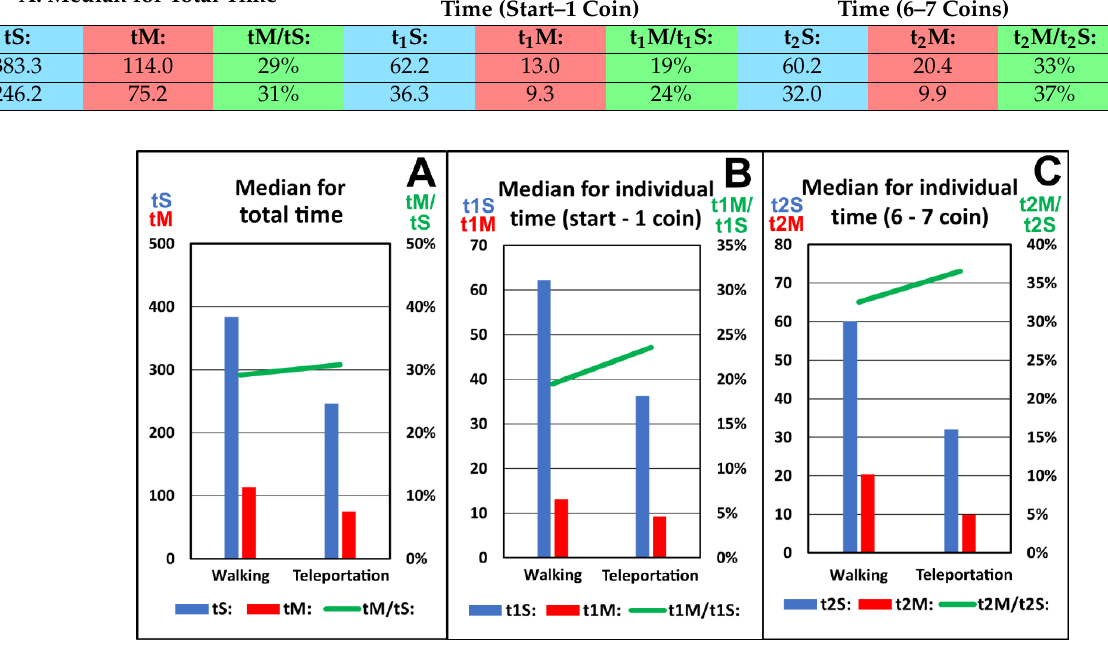
Figure 8. Comparative visualization of time for walking and